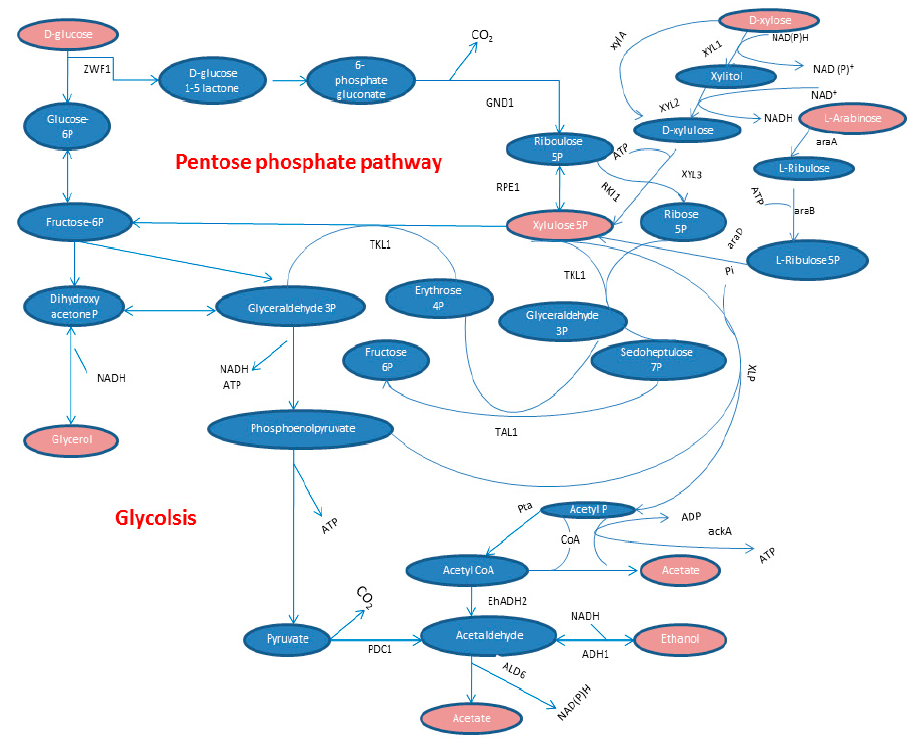
Figure 3. The pentose phosphate pathway (PPP) in yeasts.